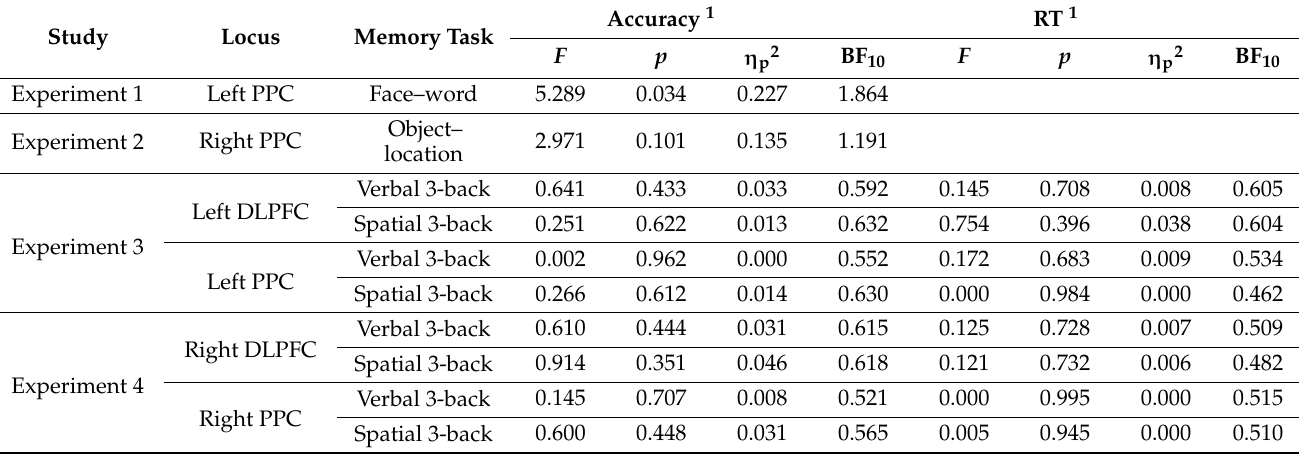
Table A2. The main effects of the sham guess factor on accuracy and RTs in mixed ANOVA (Experi- ments